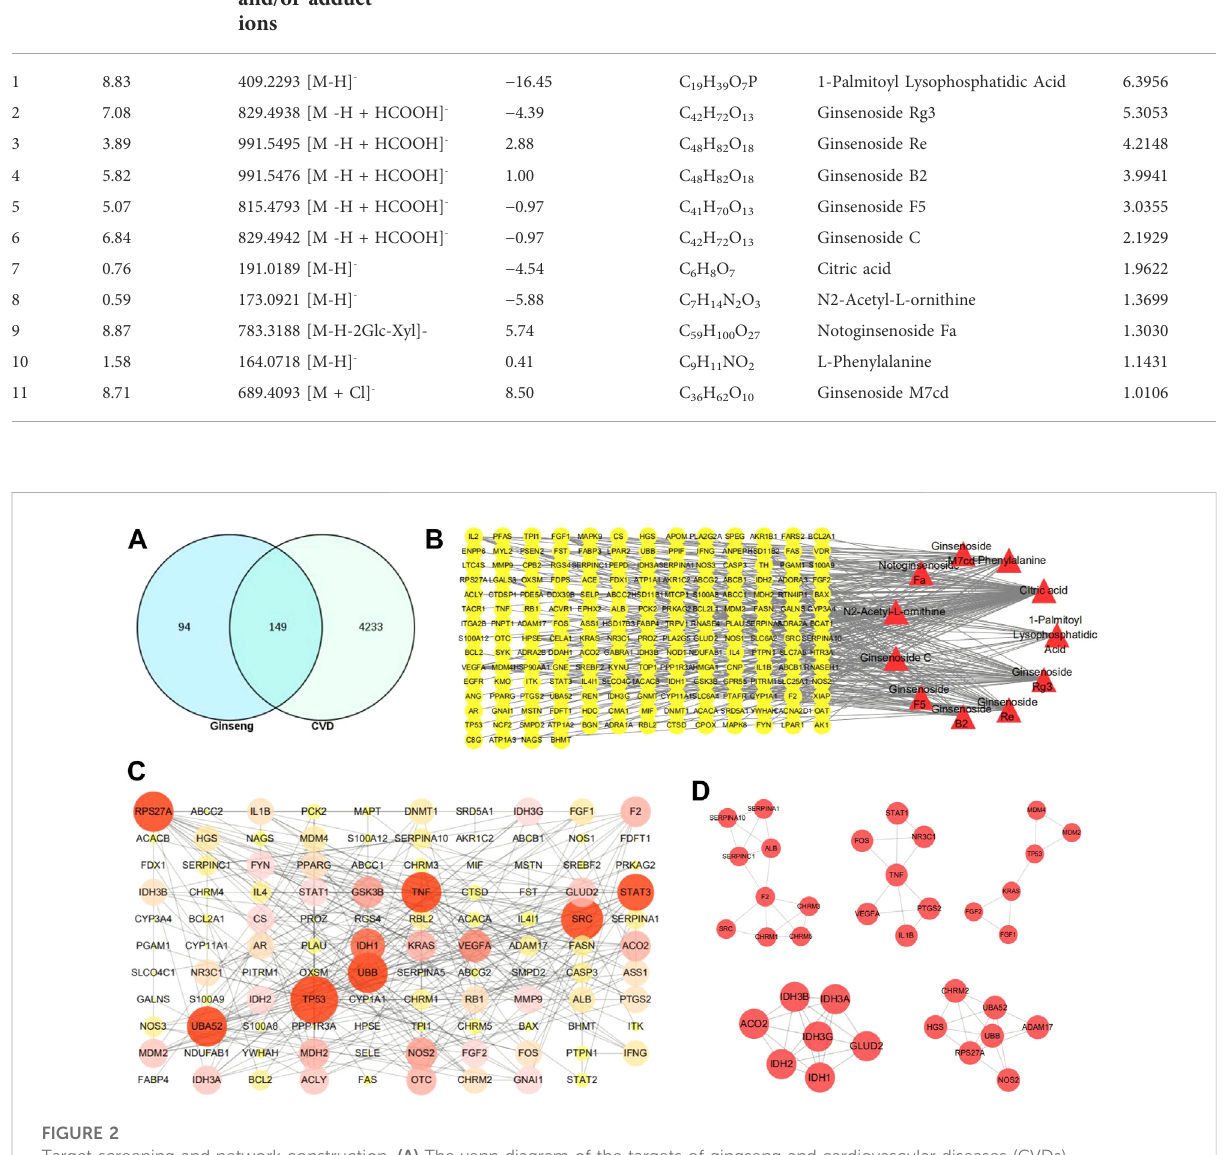
TABLE 1 Eleven differential metabolites between mountain-cultivated ginseng and garden ginseng. No.